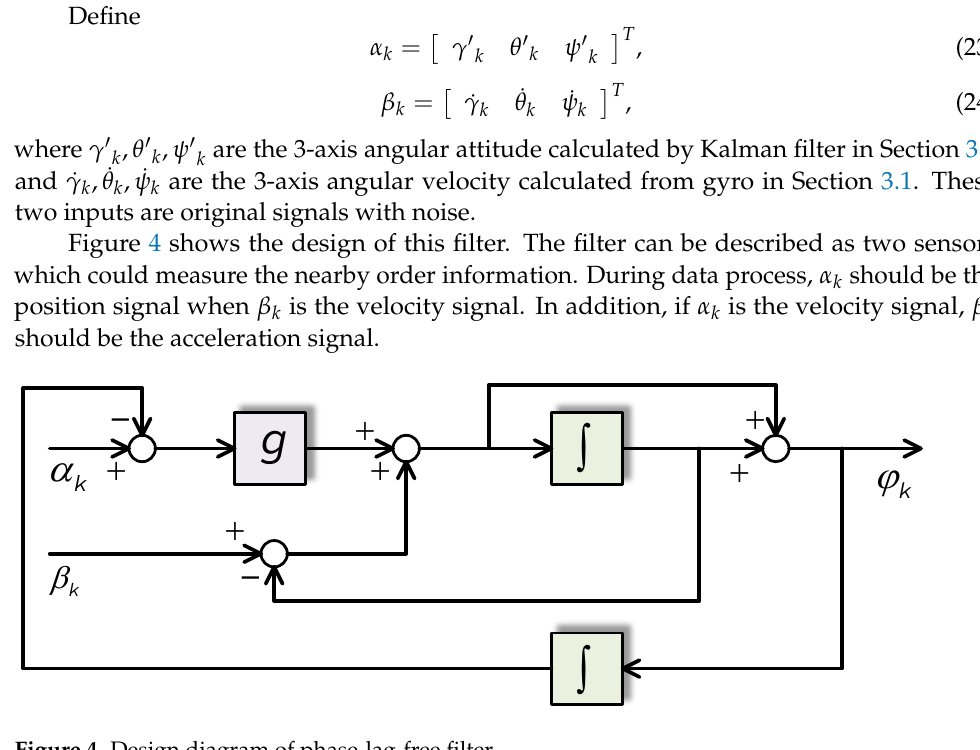
Figure 4. Design diagram of phase-lag-free